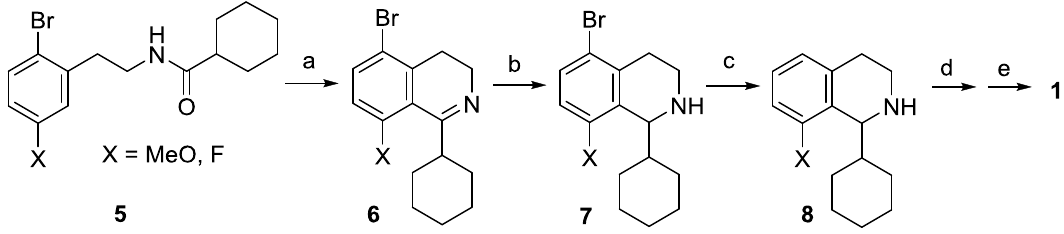
Figure 1. 1,8-Disubstituted tetrahydroisoquinoline target compounds ( 4 ) and their closest analogies ( 1 – 3 ) from the medicinal chemistry